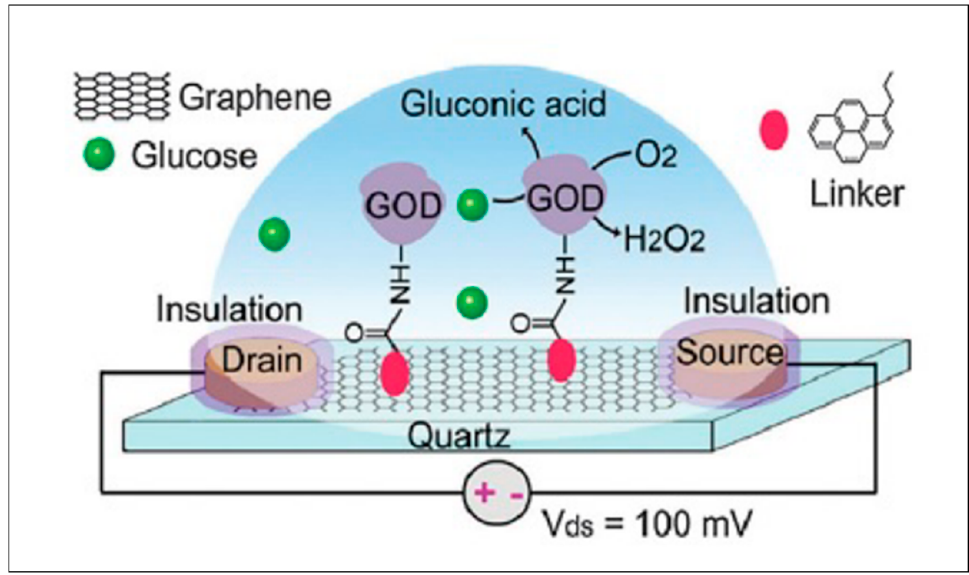
Figure 7. Illustration of a FET system for glucose detection using a graphene-based platform. (Re- produced from Ref. [92] with permission from